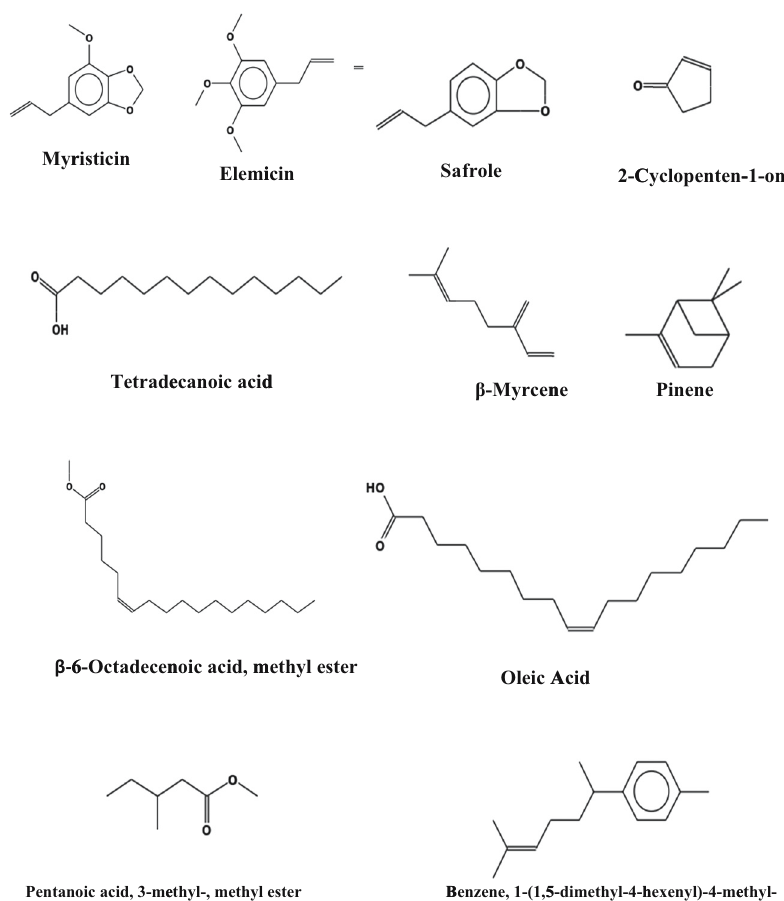
Figure 5: Some of the active compounds isolated from Myristica fragrans extract and reported in the